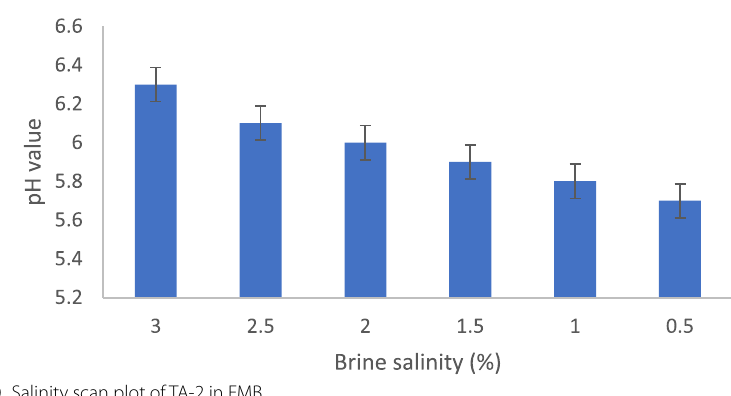
Fig. 10 Salinity scan plot of TA-2 in